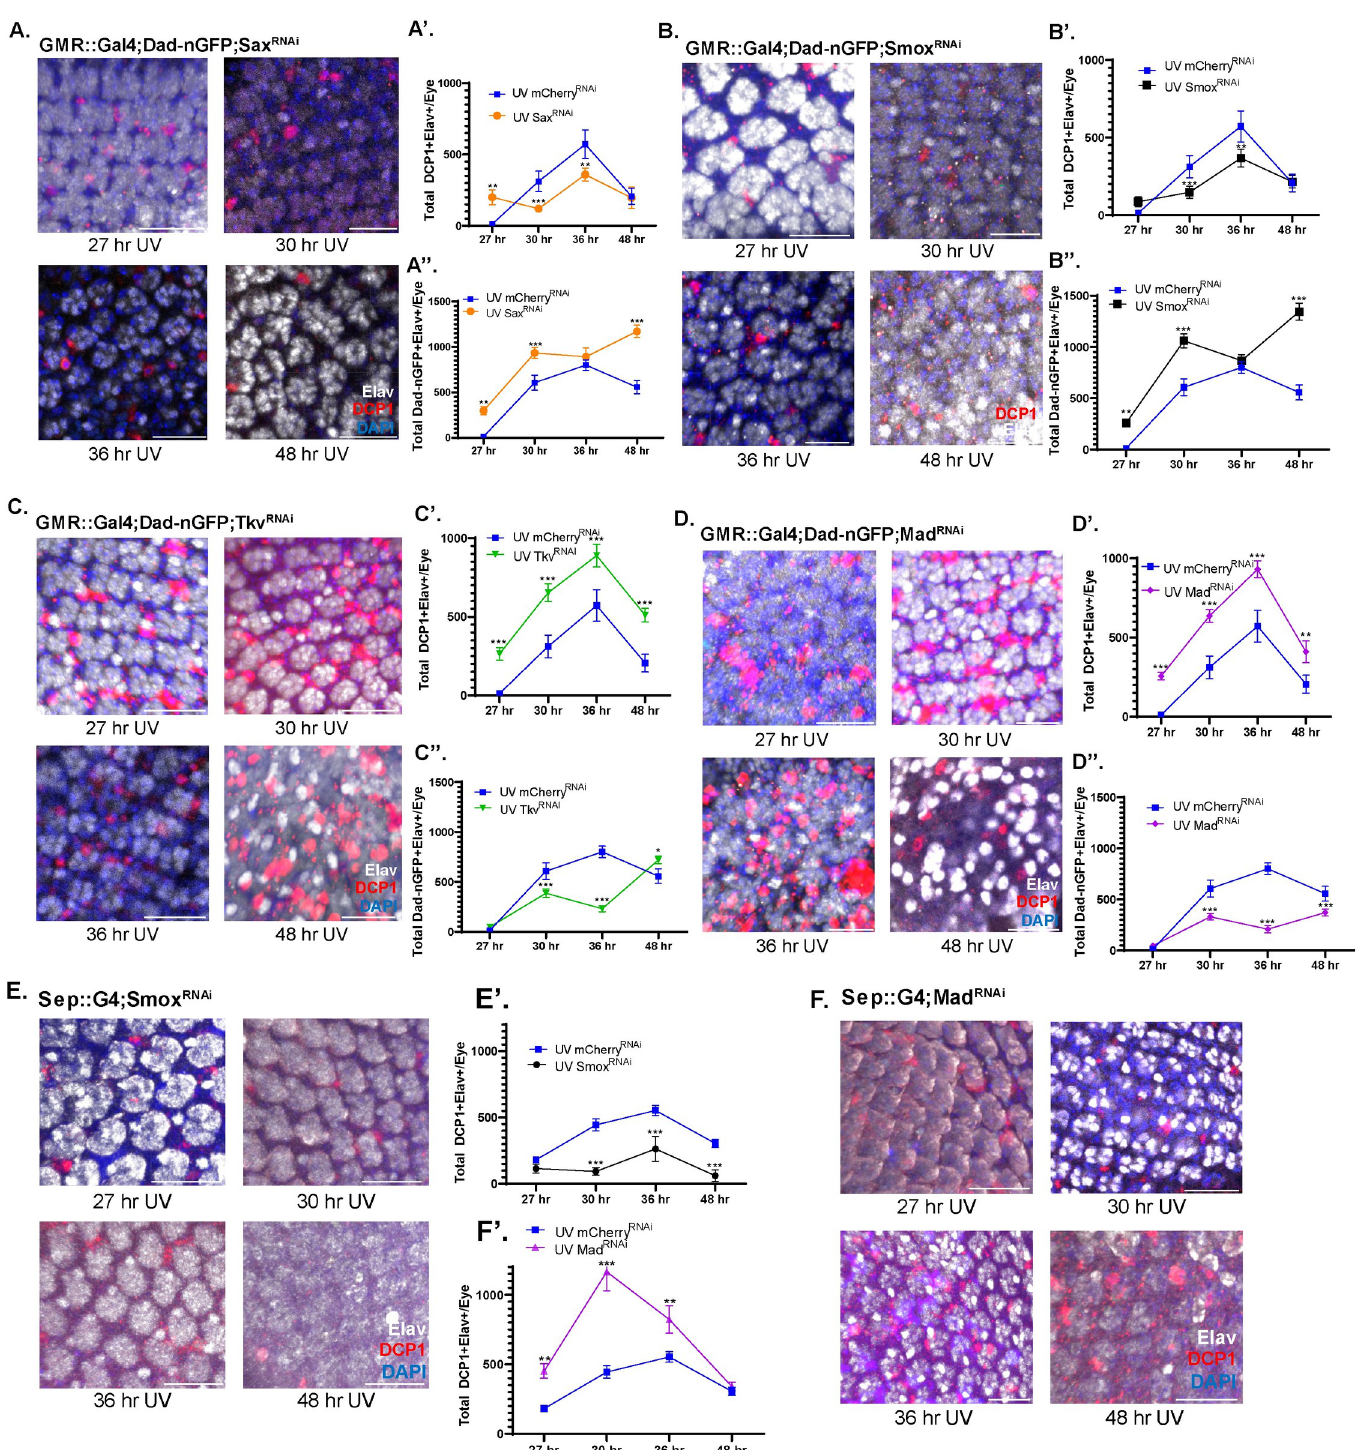
Fig 2. Following UV driven whole eye radiation damage, Sax and Smox RNAi inhibit apoptosis, while Mad and Tkv RNAi promote it. Representative images and quantitation of total DCP1+ Elav+ cells (2-A’; 2B-B’) or DadnGFP+ Elav+ cells (2A”-S2A”‘; 2B”-S2B”‘) in maturing GMR::Gal4;Dad-nGFP/ Sax-RNAi and Smox-RNAi progeny compared to controls. Representative images and quantitation of total DCP1+ Elav+ cells (2C-C’; 2D-D’) or DadnGFP+ Elav+ cells (2C”-S2C”‘; 2D”-S2D”‘) in maturing GMR::Gal4;Dad-nGFP/ Tkv-RNAi and Mad-RNAi progeny compared to controls. Representative images and quantitation of total DCP1+ Elav+ cells (2-E-E’; 2F-F’) in maturing Sep::Gal4;/ Smox-RNAi and Mad-RNAi progeny compared to controls. Scale Bar: 20 μ m. Experiments were conducted with n = 2 replicates and n = 3–5 eyes/timepoint. Error bars indicate s.e.m. P-values from Student’s t-test. � p < 0.05, �� p < 0.01, �� p < 0.001. https://doi.org/10.1371/journal.pone.0258872.g002 PLOS ONE | https://doi.org/10.1371/journal.pone.0258872 October 26,